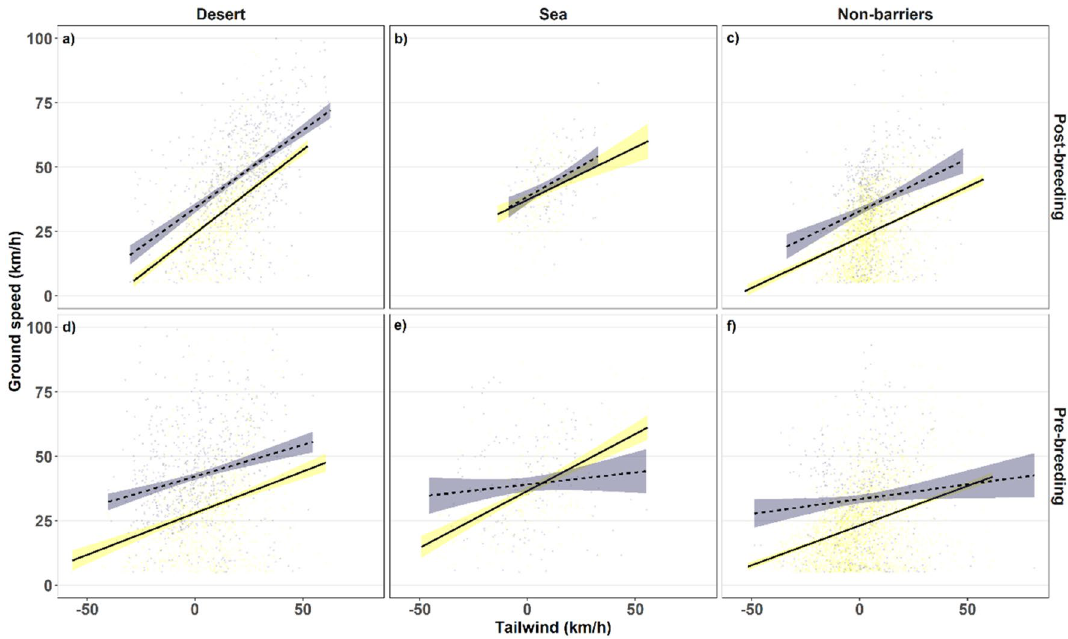
Figure 4. Ground speed in relation to tailwind along the kestrel’s routes accounting for season and geography. We show the linear relationship between hourly speed and tailwind (including only travel segments) and the effects during the post-breeding migration over barriers ( a ) desert and ( b ) sea, and, ( c ) non-barriers and during the post-breeding migration over ( d ) desert, ( e ) sea and ( f ) non-barriers, accounting for diurnal (solid yellow line) and nocturnal migration (blue dashed